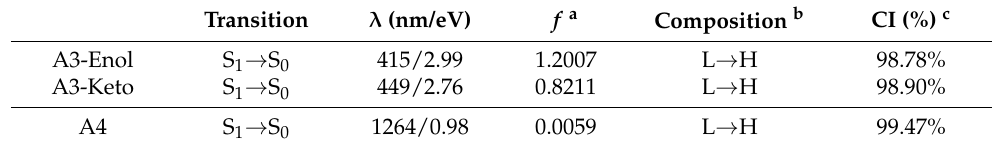
Table 2. B3LYP-D3/TZVP/IEFPCM levels calculated emission energies (nm), corresponding oscillator intensities and corresponding compositions for the A3 and A4